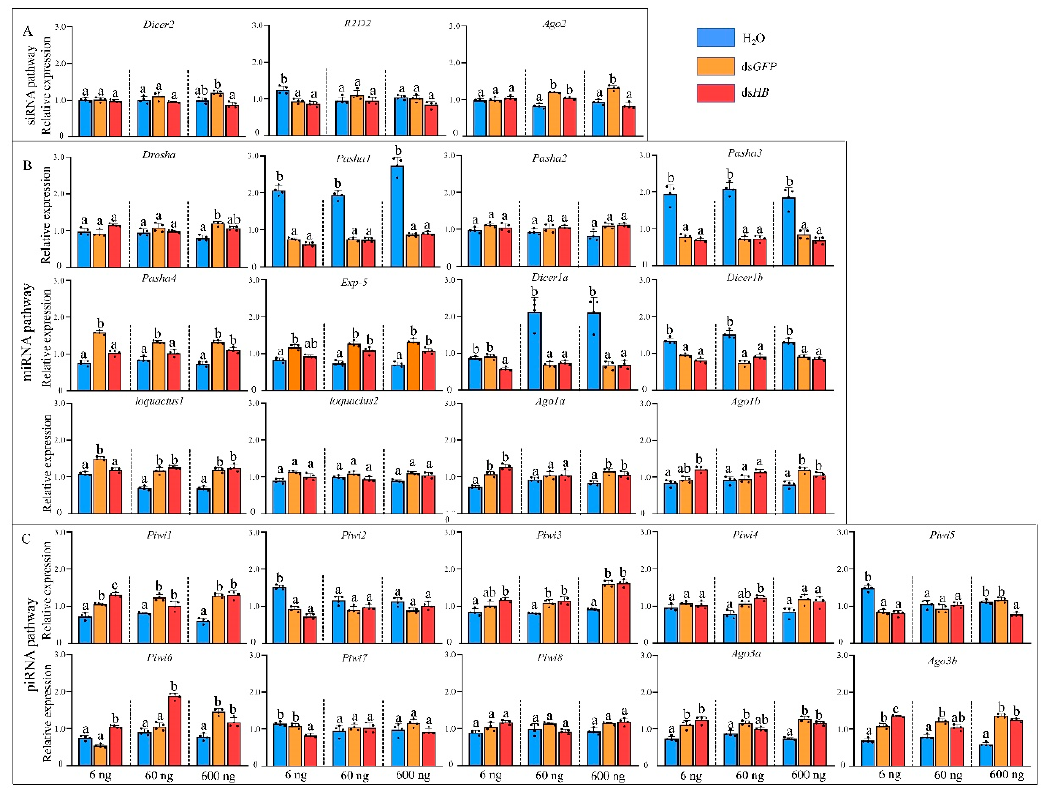
Figure 3. Expression profiles of core genes of three RNAi pathways upon dsRNA administration by microinjection. ( A ) siRNA pathway. ( B ) miRNA pathway. ( C ) piRNA pathway. Different colors represent different level of changes. Mean (±SE) expression level was based on four biological replicates. The relative expression was normalized based on two reference genes, A. pisum elongation factor-1 alpha ( EF1 α ) and ribosomal protein S2-like ( RPS2 ). Lowercase letters above each bar indicate significant differences (one-way ANOVA followed by Tukey’s honestly significant difference multiple comparison test; p < 0.01). The Significant di ff erence was analyzed in each dosage,